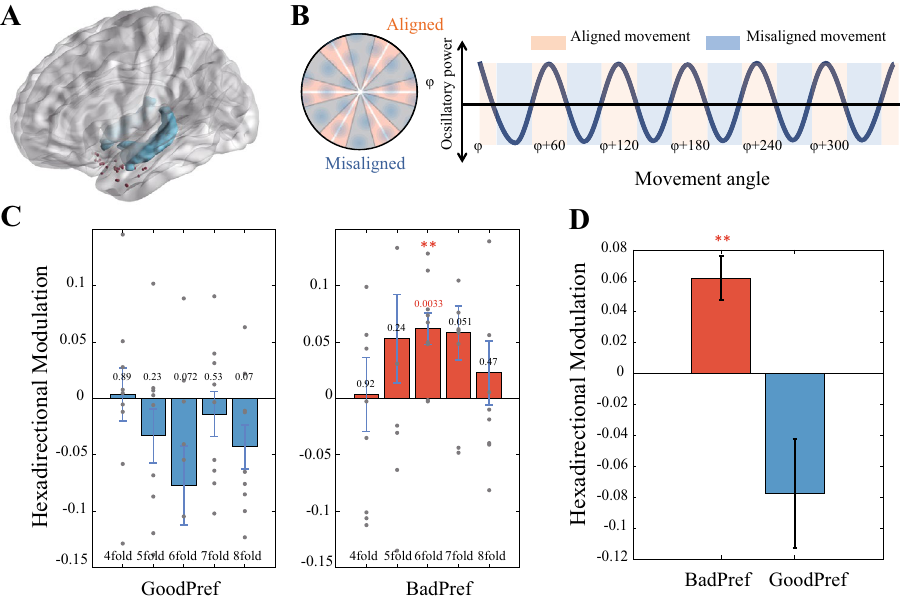
Figure 2. Hexadirectional modulation of entorhinal theta power by movement direction under the influence of goals. ( A ) Depiction of all the electrode contacts in the entorhinal cortex (red dots). ( B ) According to alignment or misalignment with the preference angle φ (left figure), we predicted the sixfold rotational symmetric sinusoidal modulation of the theta power signal by the moving direction according to the schematic diagram (right, adapted from Maidenbaum et al. (PNAS, 2018)). ( C ) GoodPerf and BadPerf groups correspond to each rotational symmetric modulation, among which only the sixfold modulation of the BadPerf was significant ( t test, p = 0.003). ( D ) The BadPerf had significantly higher hexadirectional modulation than the GoodPerf ( t test, p <